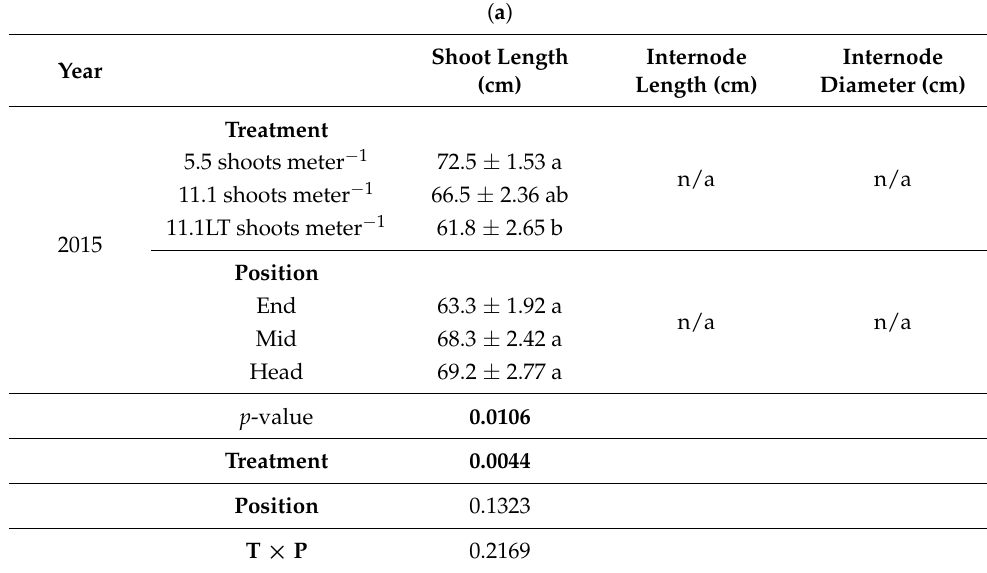
Table 4. Two-way analysis of variance (ANOVA) with interaction showing average shoot length (cm), internode length (cm), and internode diameter (cm) by year, treatment, and cordon position at v é raison during the 2015 ( a ), 2016 ( b ), and 2017 ( c ) growing seasons ( n = 8). Table shows treatment means followed by the standard error of the mean. Different letters within a column indicate significant differences based on an Each pair, Student’s t -test. Significant p -values (<0.05) are displayed in